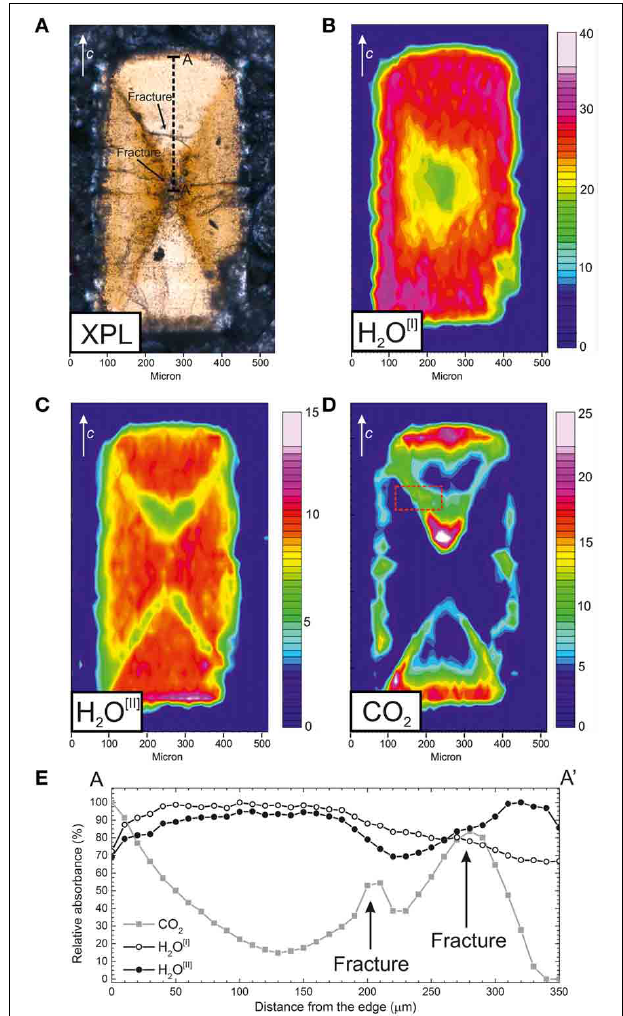
FIGURE 5 | (A) Crossed polars optical image (XPL) of the treated beryl sample. Polarized-light FPA-FTIR images of (B) H 2 O [ I ] distribution, E// c , integration range 3740–3655cm − 1 , (C) H 2 O [ II ] distribution, E// c , integration range 3630–3577cm − 1 , and (D) CO 2 distribution, E ⊥ c , integration range 2396–2325cm − 1 . Chromatic scale is proportional to H 2 O and CO 2 contents. Data collected under using Globar FTIR light. (E) absorbance profiles along